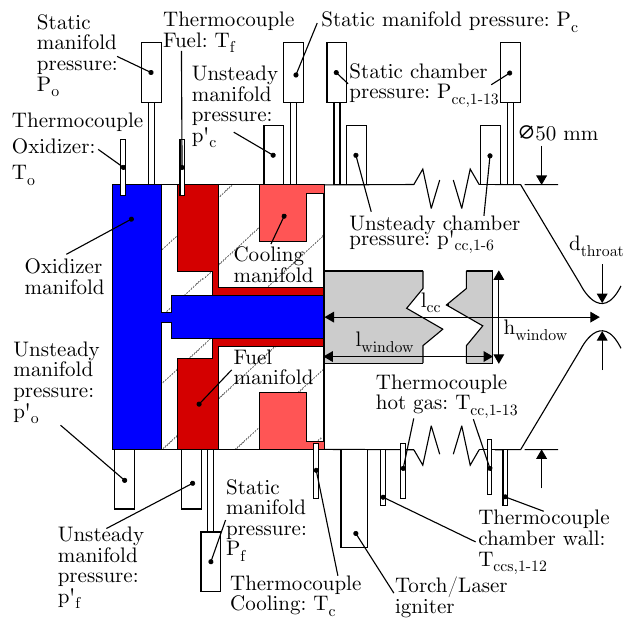
Figure 1. Experimental combustion chamber